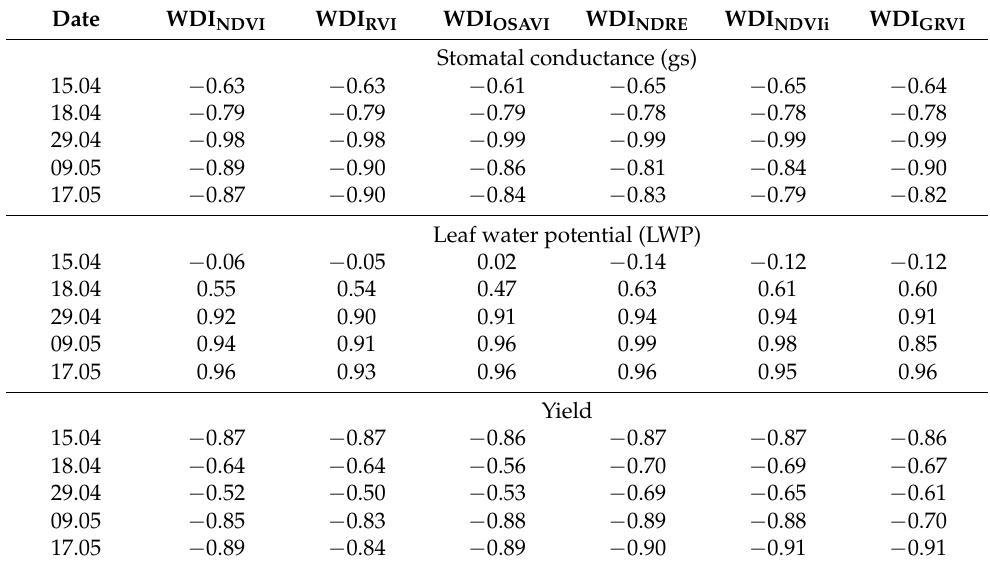
Table 5. WDI correlation to stomatal conductance, leaf water potential, and yield based on WDIs derived from different multispectral indices for the April–May